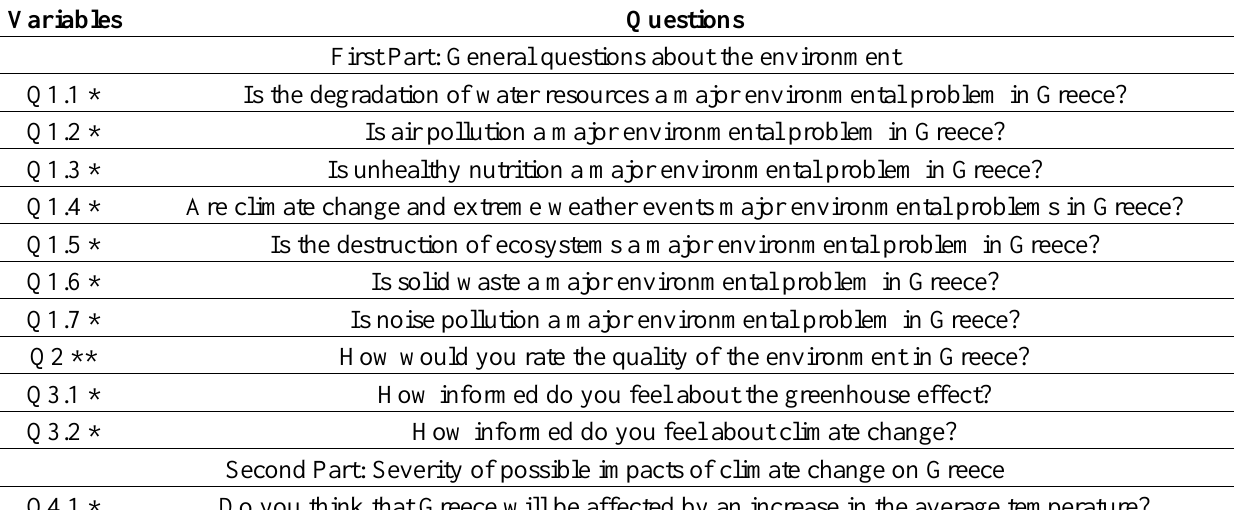
Table 1. The questionnaire used in this